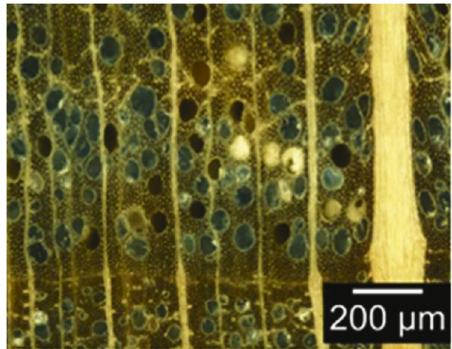
Figure 13: The cross section of wax - treated material under a light microscope [ 112 ] .